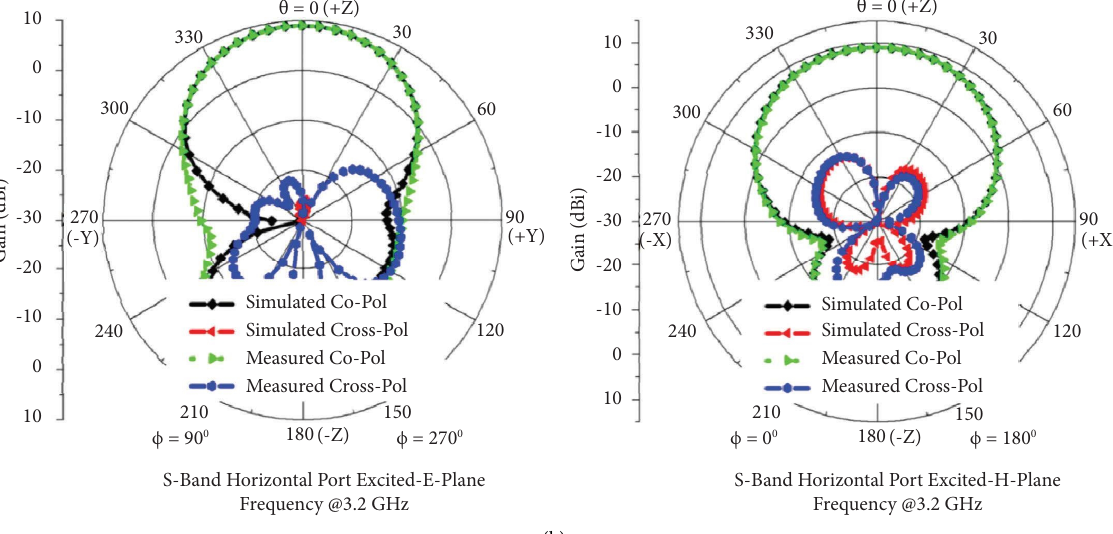
Figure 12: (a) Simulated and measured radiation pattern of port-1 excited phi � 0 ° -plane @3.2 GHz and port-1 excited phi � 90 ° -plane @3.2GHz. (b) Simulated and measured radiation pattern of port-2 excited phi � 90 ° -plane @3.2 GHz and port-2 excited phi � 0 ° -plane